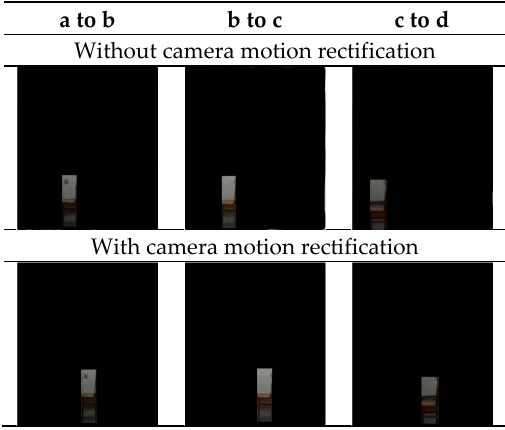
Figure 7. The results of the motion segmentation.